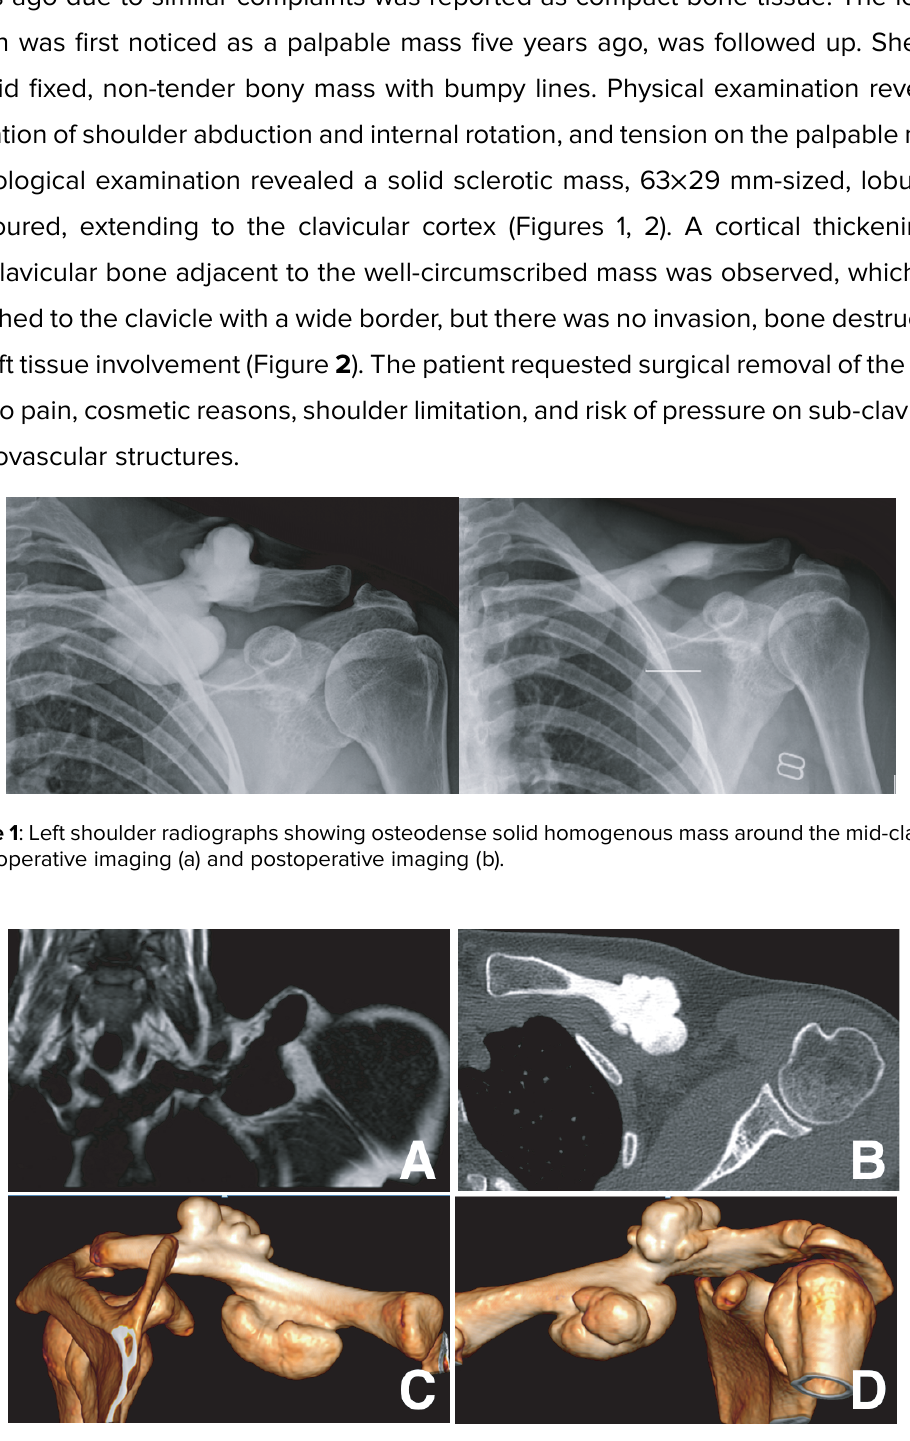
Figure 2 : Radiological images of left clavicular parosteoal osteoma (a) scintigraphic cold uptake imaging, (b) computerized tomography axial imaging, (c) 3-dimensional imaging from posterior aspect, and (d) 3- dimensional imaging from anterior